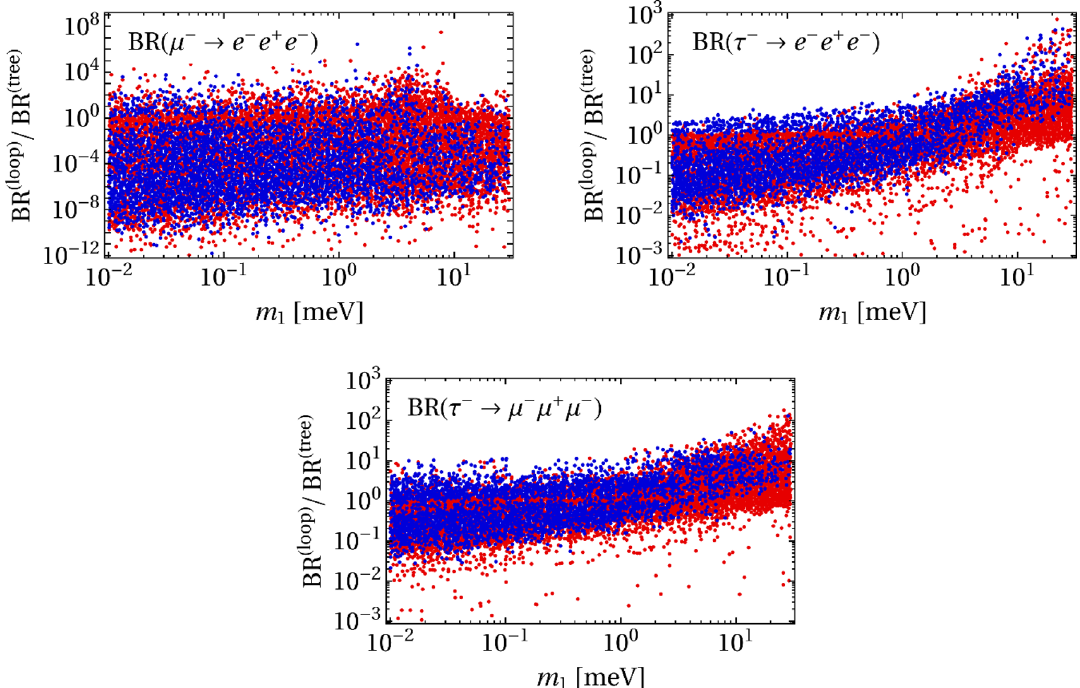
Figure 5 . Scatter plots of BR (loop) / BR (tree) for the decays µ − → e − e + e − (top-left panel), τ − → e − e + e − (top-right panel), and τ − → µ − µ + µ − (bottom panel). The points are the ones used in figure 4, with the same colour coding as